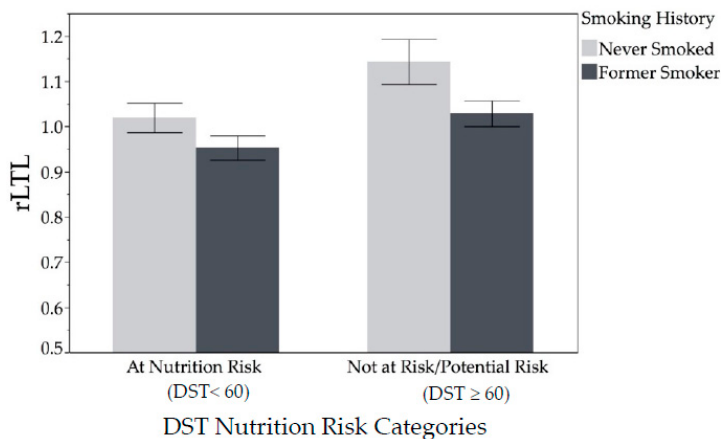
Figure 2. Relative leukocyte telomere length (rLTL) by smoking history and nutrition risk category ( n = 92) analyzed using multivariate modeling. Participants who had never smoked had higher rLTL than those who were former smokers across both categories of nutrition risk. Likewise, those who are not at nutrition risk had higher rLTL across both categories of smoking. Those who had never smoked and were not at nutrition risk had the longest rLTL, although there was no significant interaction effect detected. Abbreviation: DST, Dietary Screening Tool.